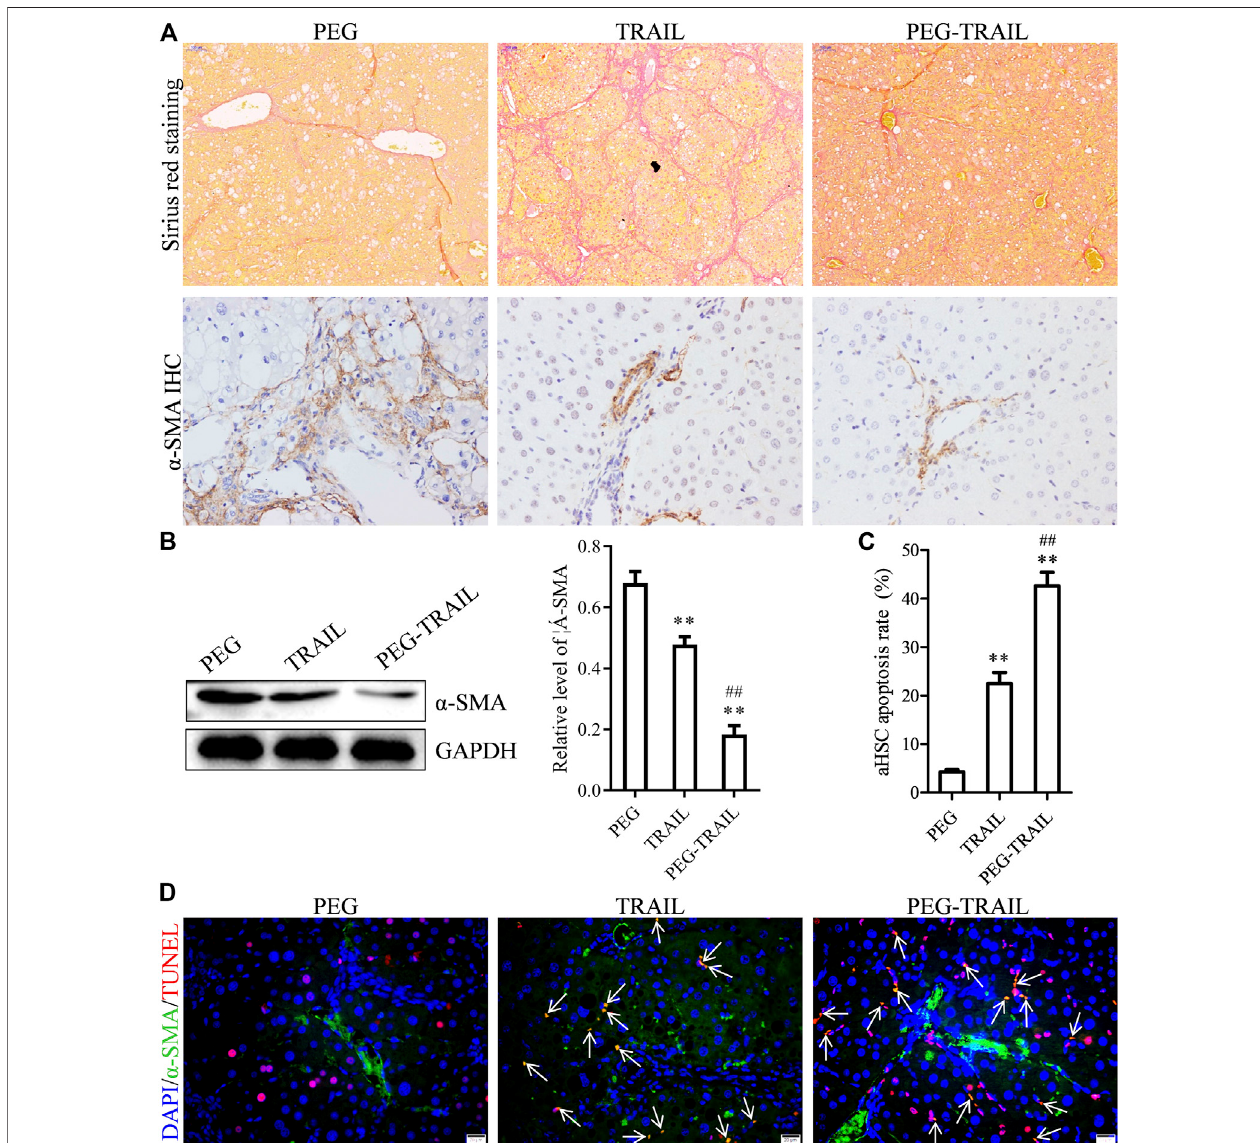
FIGURE 4 | PEG-TRAIL enhances anti fi brotic and proapoptotic effects of TRAIL in hepatic fi brosis mice models. (A) Sirius red staining and α -SMA IHC of liver tissuesafter treatment with PEG,TRAIL, or PEG-TRAIL. (B) Westernblottingshowing theprotein expression level of α -SMAin the liver tissues after treatment with PEG, TRAIL, and PEG-TRAIL. (C,D) TUNEL/ α -SMA double-labeling IF of liver tissues after treatment with PEG, TRAIL, or PEG-TRAIL, and the corresponding quantitative apoptosisrate ofaHSCs inliver tissues (C) . Arrows indicate TUNEL + / α -SMA + cells. Scalebar: 20 μ m. ** p < 0.01,comparedwith PEG;## p < 0.01, compared with